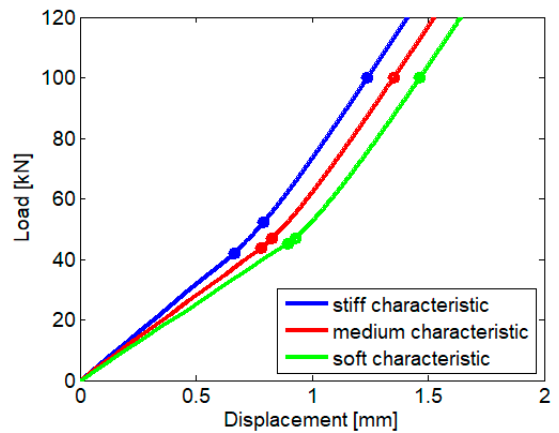
Figure 11. Load–rail displacement characteristic.